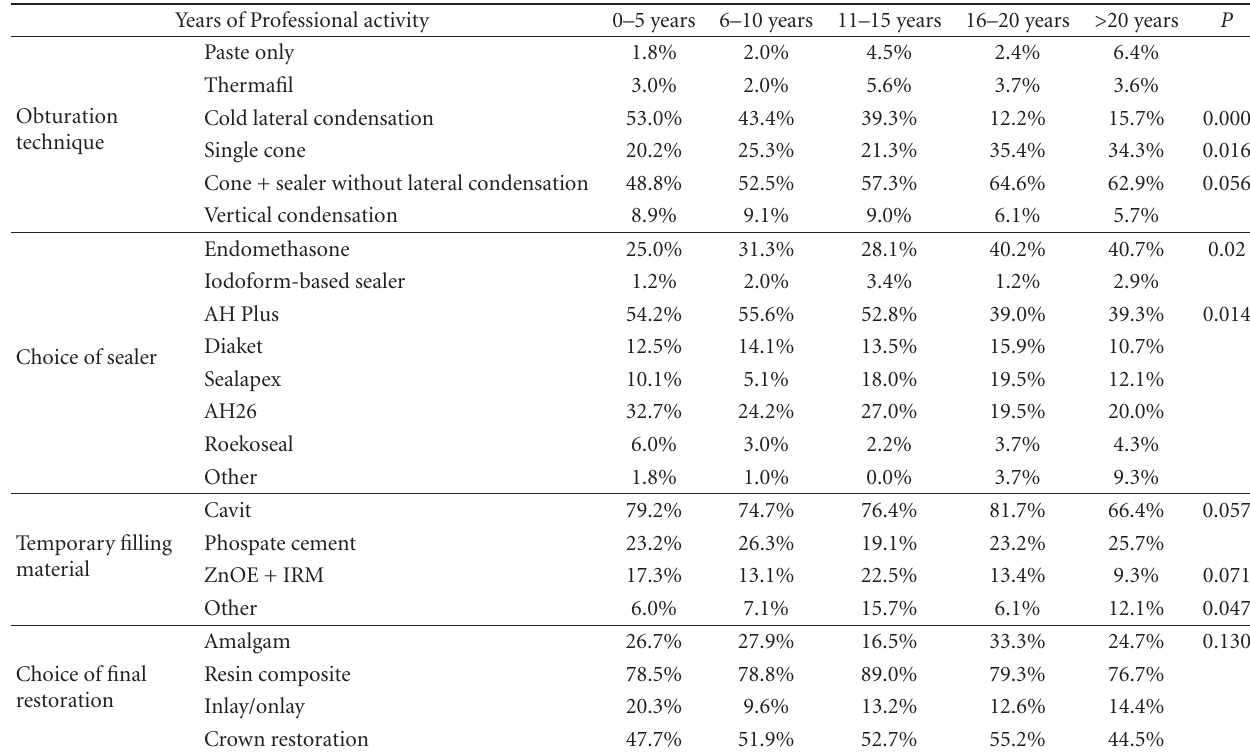
Table 5: Choice of obturation technique, sealer, temporary filling material, and permanent filling material according to the years in dental